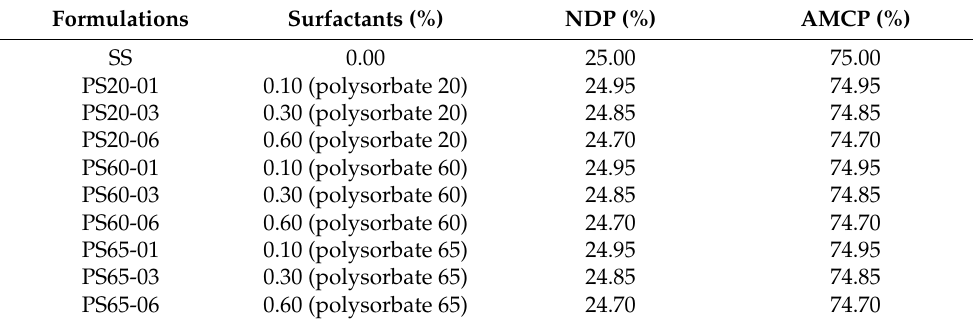
Table 1. The content of surfactants, NDP, and polymer in the solid solution formulation.